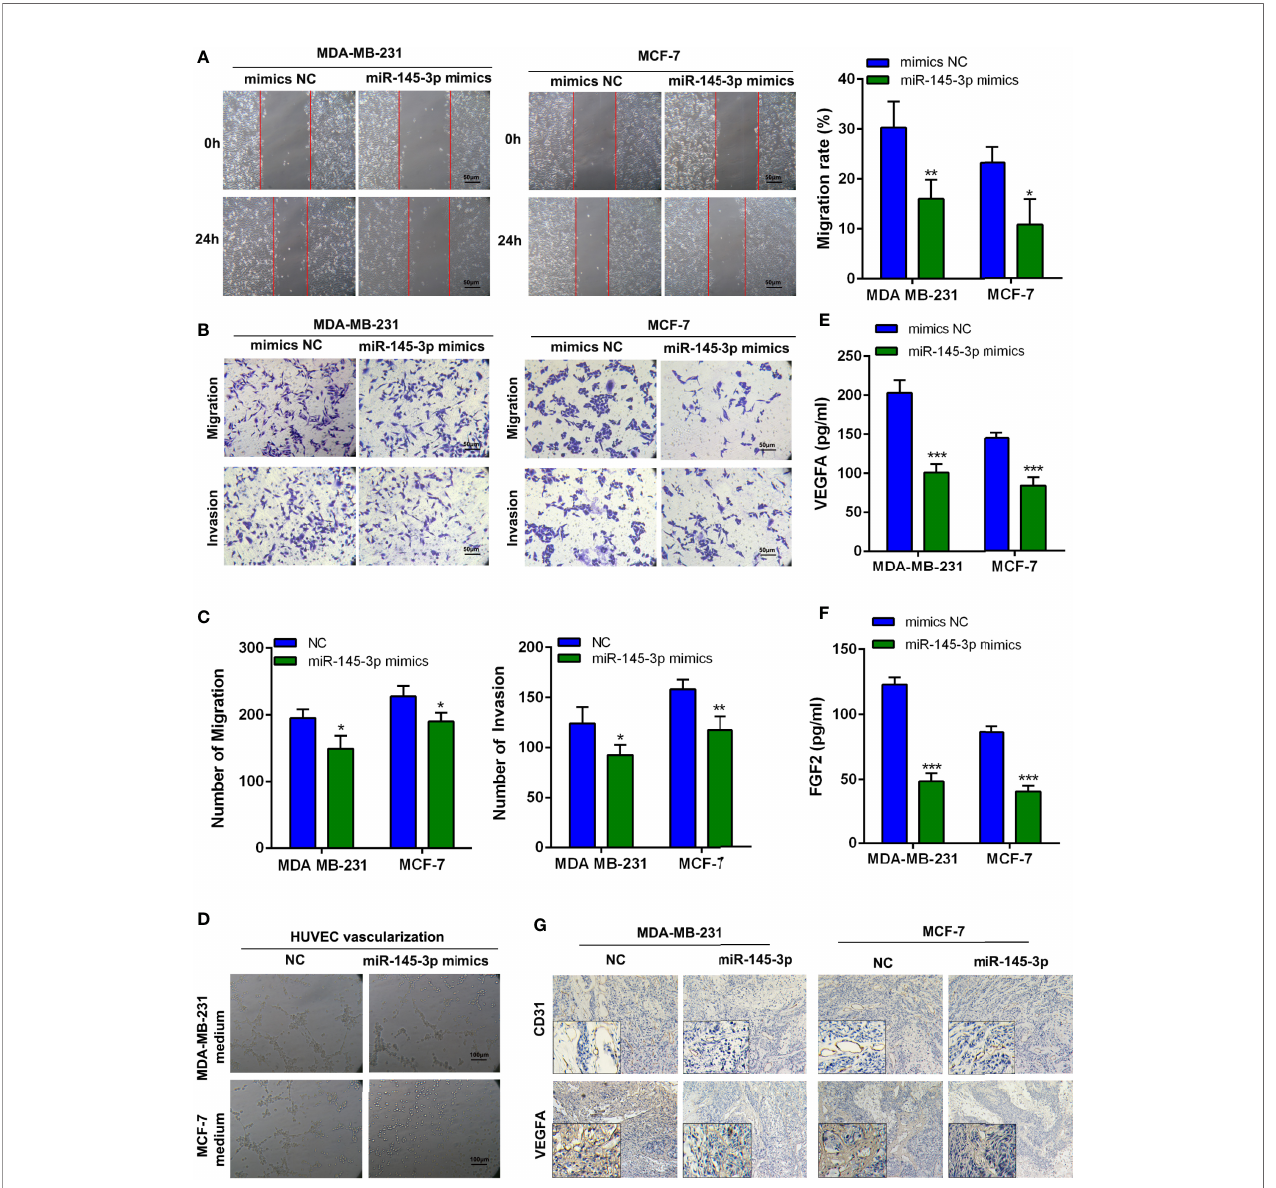
FIGURE 5 | MiR-145-3p promotes breast cancer cells migration, invasion, and angiogenesis in vitro (A) Wound healing assays were used to assess migration of breast cancer cells transfected with miR-145-3p mimics. (B, C) Transwell assay was used to assess migration and invasion of breast cancer cells transfected with miR-145-3p mimics. (D) Tube formation of HUVEC cell was detected and results were expressed as number of branches. (E, F) The protein level of VEGFA and FGF2 in CM by ELISA assays. (G) The expression of VEGFA and CD31 in the xenografts was examined by IHC. * P < 0.05, ** P < 0.01, *** P <